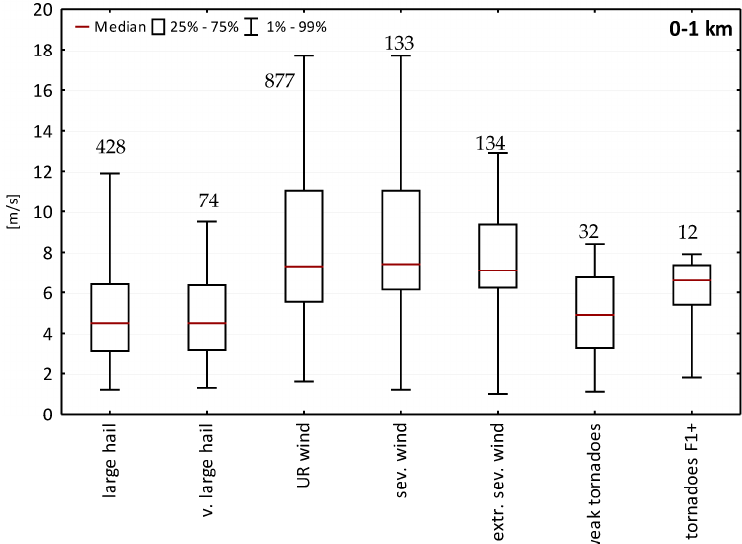
Figure 2. Box-and-whiskers plot of the bulk wind shear (magnitude of the vector difference between the ground level and the height of 1 km) in the proximity of the severe weather reports on the given phenomena. The box extends from the 25th to 75th percentile and the whiskers reach from the 1st (bottom part) to the 99th (upper part) percentile. The number above the 99th percentile denotes the number of severe weather reports within the given phenomena category. UR wind—unrated wind; v. large hail—very large hail; sev. wind—severe wind; extr. sev. wind—extremely severe wind.